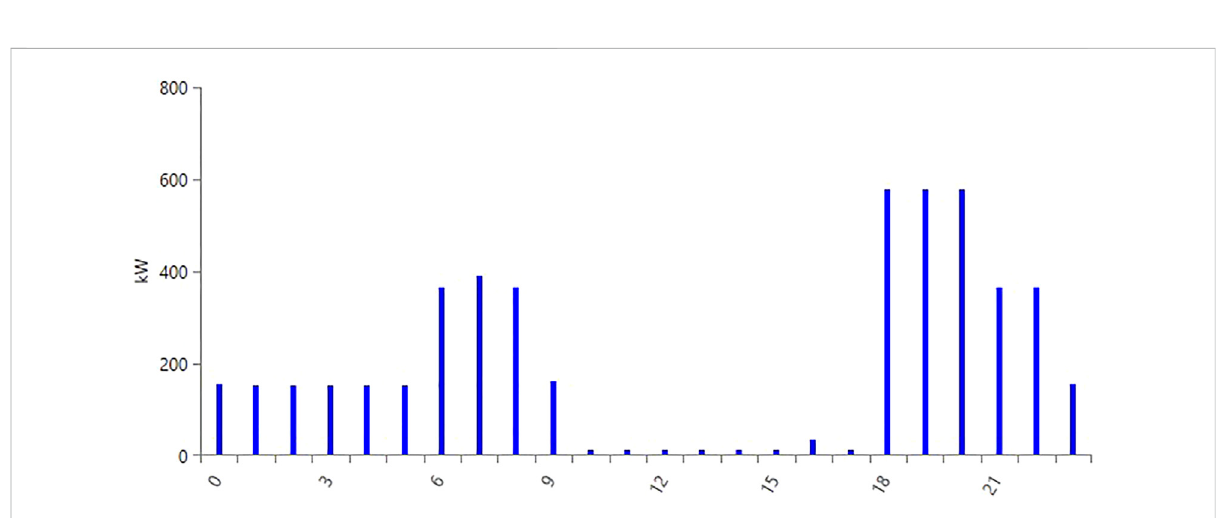
FIGURE 4 Daily hourly load pro fi le of the refugee